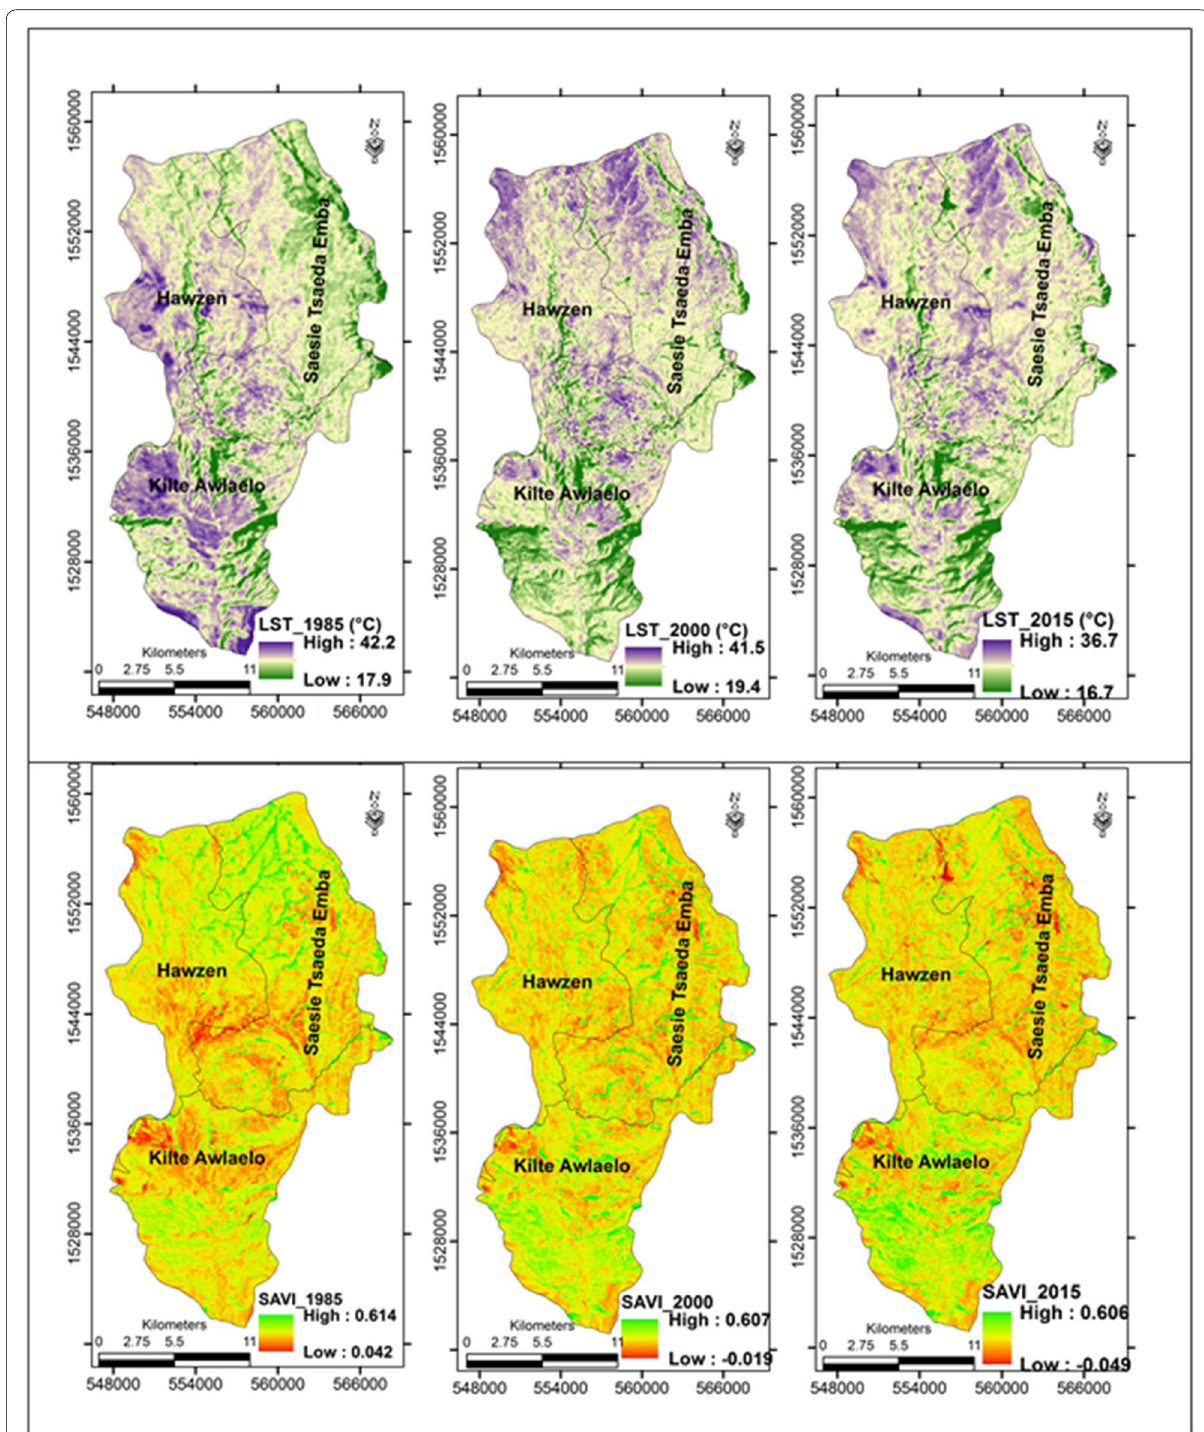
Fig. 7 LST results for 1985, 2000 and 2015 (top); SAVI results for 1985, 2000, and 2015